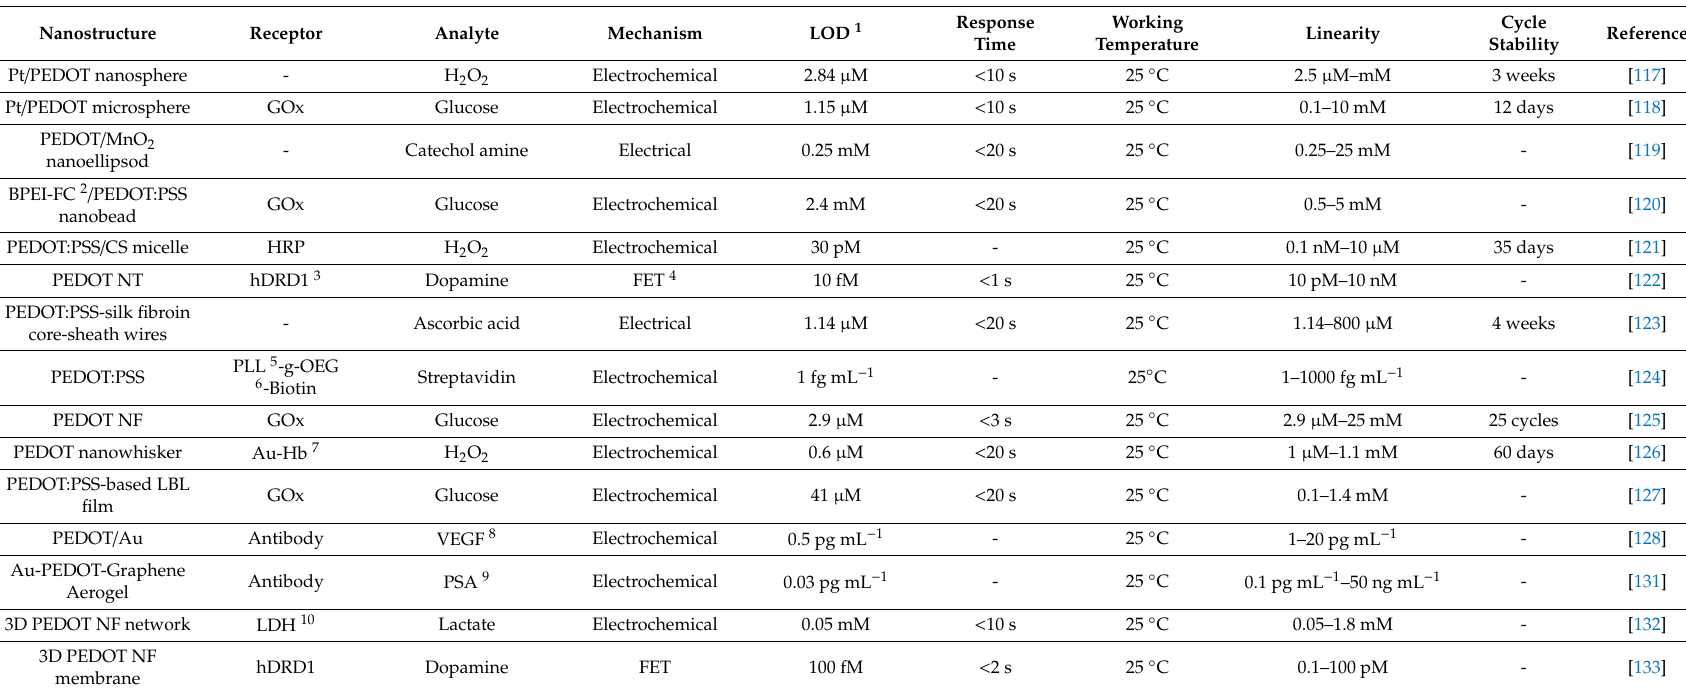
Table 3. Comparative sensing performance and limit of detection of PEDOT nanostructure-based